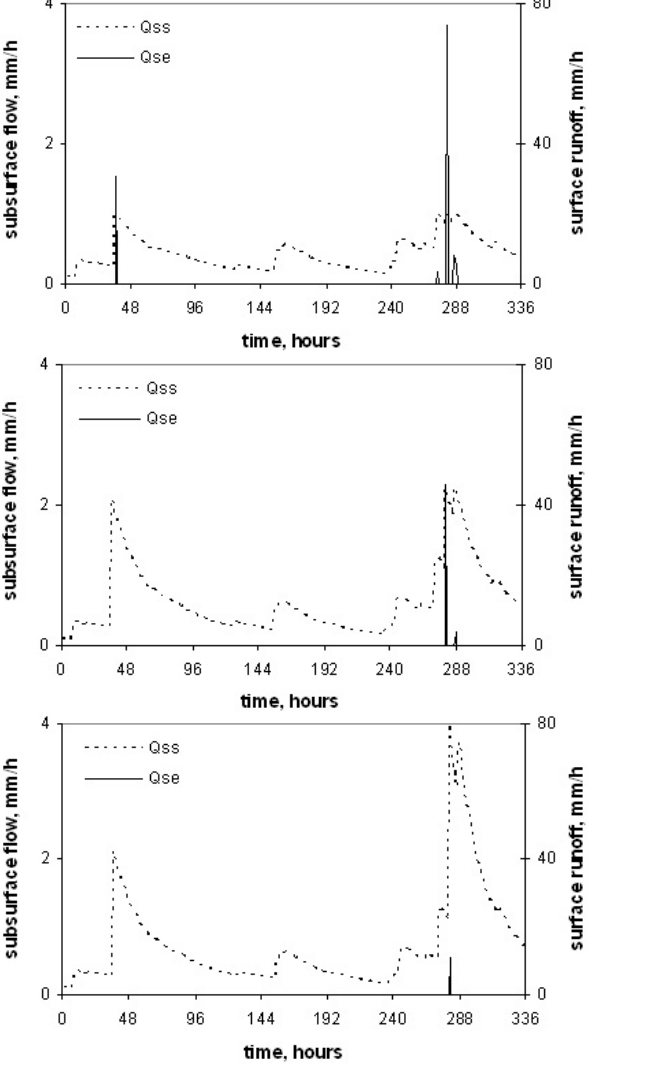
Fig. 6. The impact of within storm patterns generated by Model 4 using S b =150mm and (a) η =0.5, (b) η =1.5, and (c) η